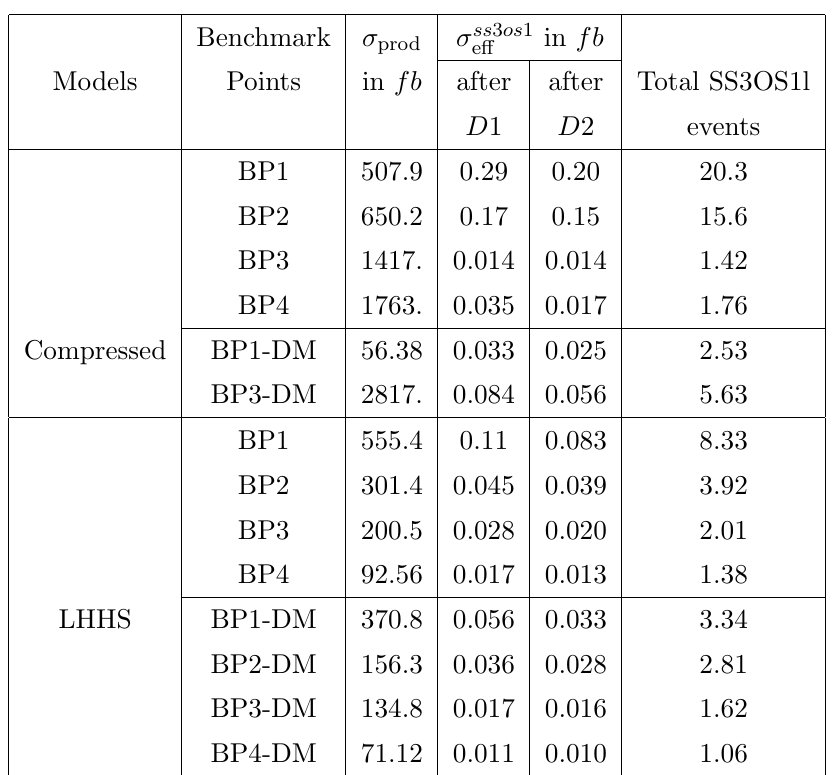
Table 15 . The production cross sections of all EWeakino pairs and (cid:27) ss 3 os 1 for the BPs de(cid:12)ned in table 5 and table 7. Also the total number of SS3OS1l events are shown for an integrated luminosity of 100 fb (cid:0) 1 .